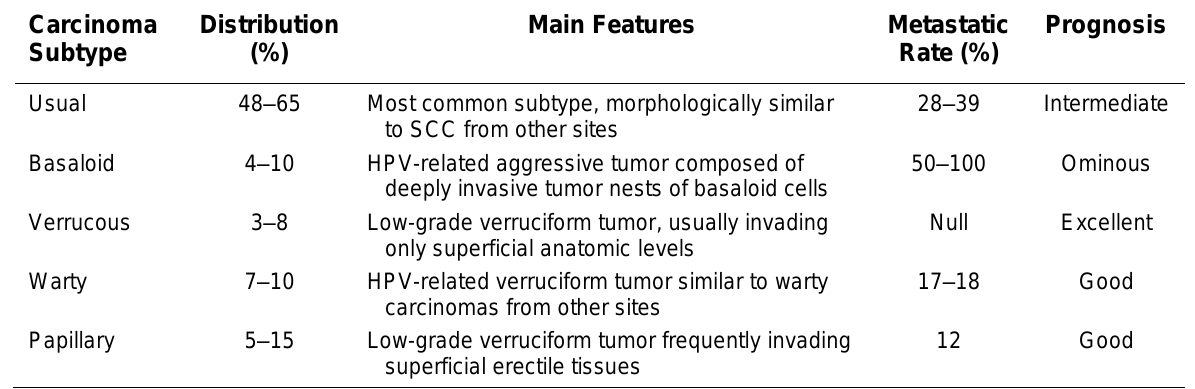
Characterization of Penile SCC Histologic Types that have Higher Distributions